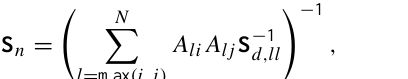
Fig. 2. Density error results for DD scenario (bold lines) and SD scenario (light lines). Left panel: absolute (solid lines) and relative (dashed lines) stan- dard deviation of density retrieval er- rors; mean density profile (dotted line). Right panel: correlation functions for three representative heights, ∼ 60 km (dashed line), ∼ 75 km (dotted line), and ∼ 90 km (solid